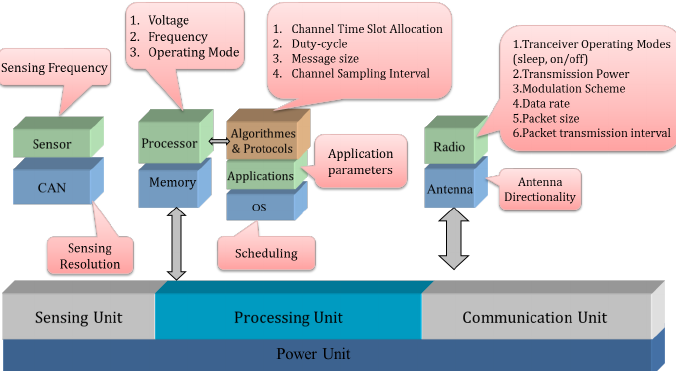
Figure 1. Parameters Involved within a Low-Power Sensor Node.